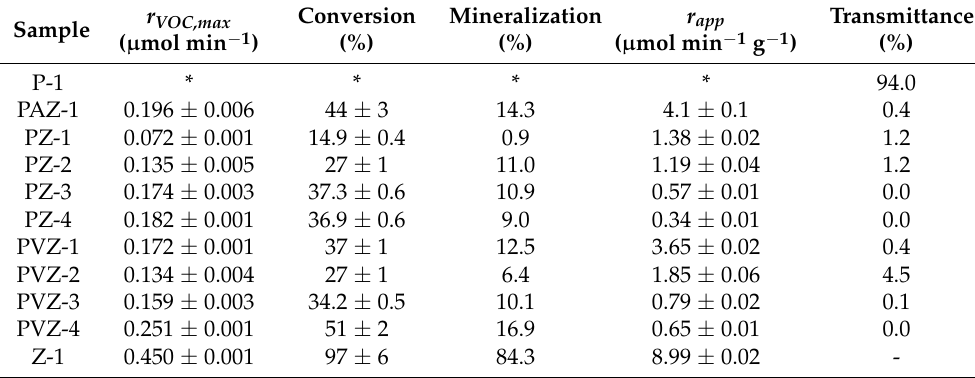
Table 4. n -Decane maximum conversion rate ( r VOC,max ), conversion, mineralization, and